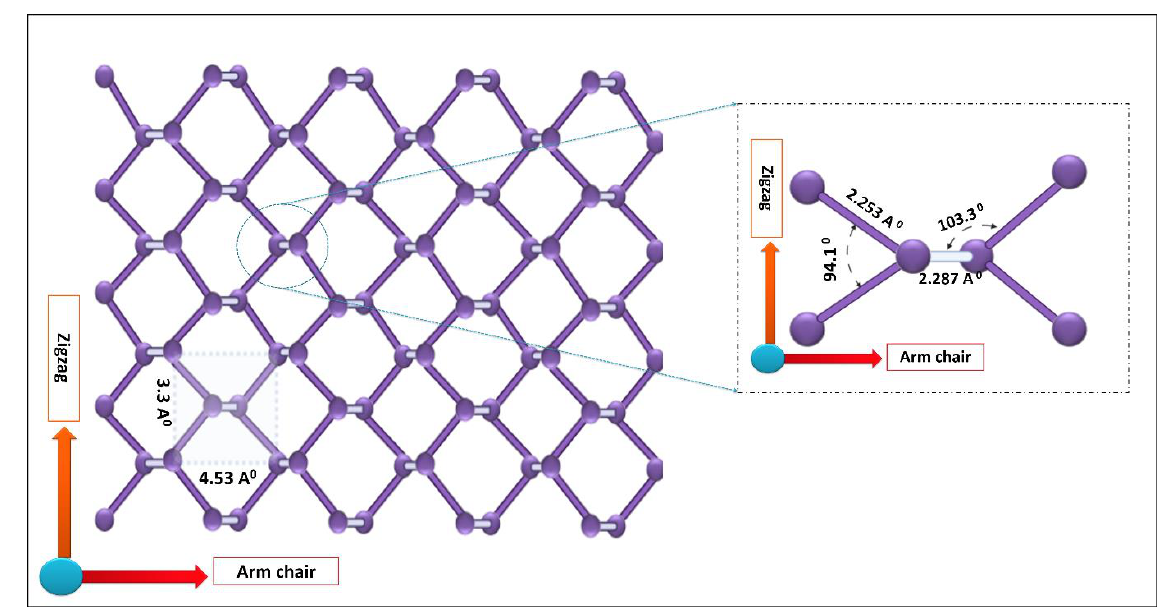
Figure 3. Schematic illustration of the structure of black phosphorus. Table 1. Important characteristics of BP nanomaterials for biomedical applications.